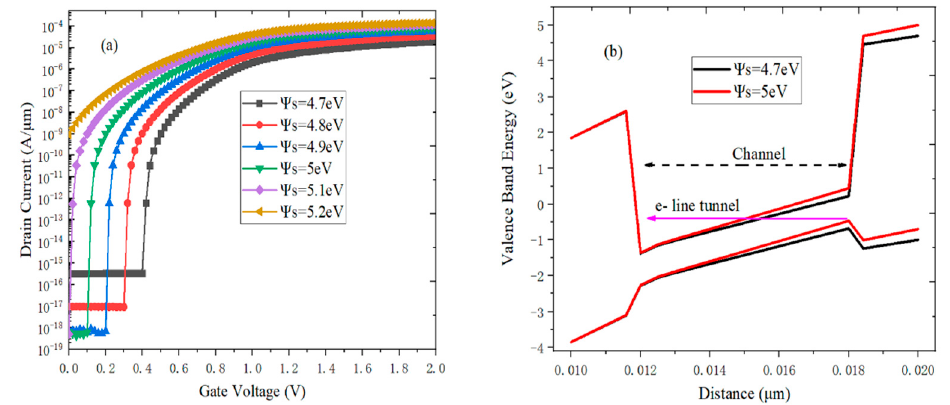
Figure 8. Influence of Ψ s on ( a ) the transfer characteristic and ( b ) the on-state energy band from the top channel to the bottom channel.